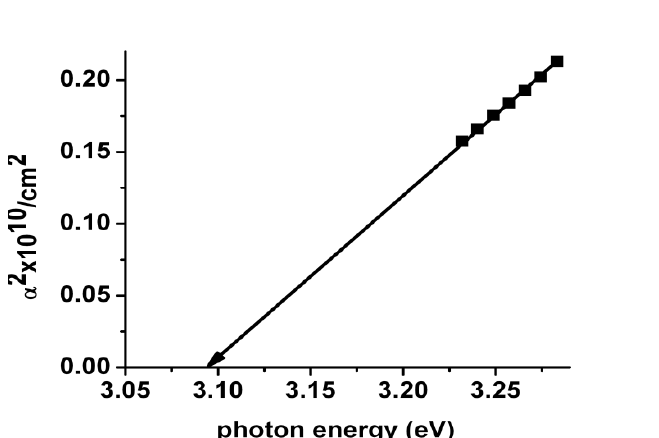
Figure 3. Plot of  2 versus hυ of ZnTTBPc thin film.